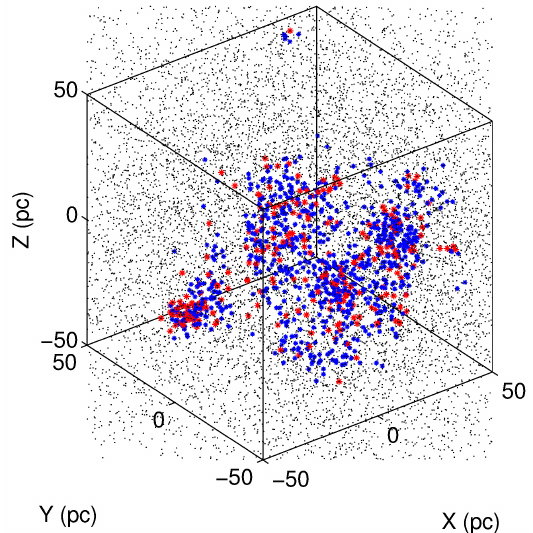
Fig. 5. Example of a spatial distribution of fractal complexes in Galactic Cartesian coordinate system ( X; Y; Z ). The red and blue asterisks are complexes of stars with [Fe/H] > 0 and [Fe/H] < 0, respectively. All complexes have fractal dimensions D that differ by more than three standard deviations from the corresponding dimension of a random distribution ( D > mean D + 3 (cid:27) RD ). The scale factor is equal to Mf = 8. units of the third or fourth decimal place (depending on the